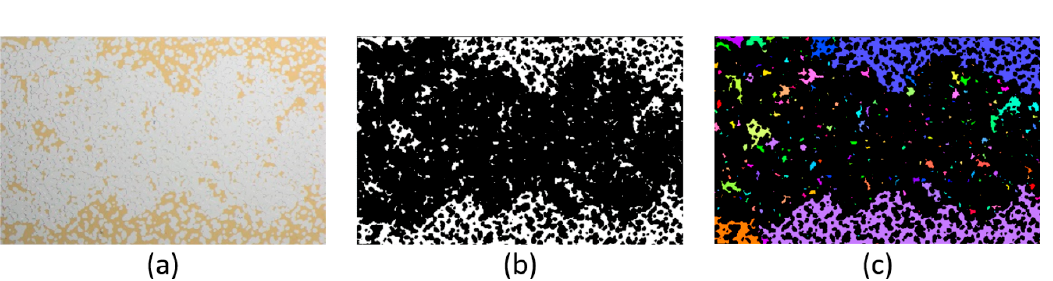
Figure 4. ( a ) Pre-processing image of a microchip (oil in gold, glass & brine in white), ( b ) a post-segmentation binary image (oil in white), and ( c ) oil clusters were labeled by pseudorandom colors for qualitative analysis. Quantitative analysis was applied to the binary image ( b ).